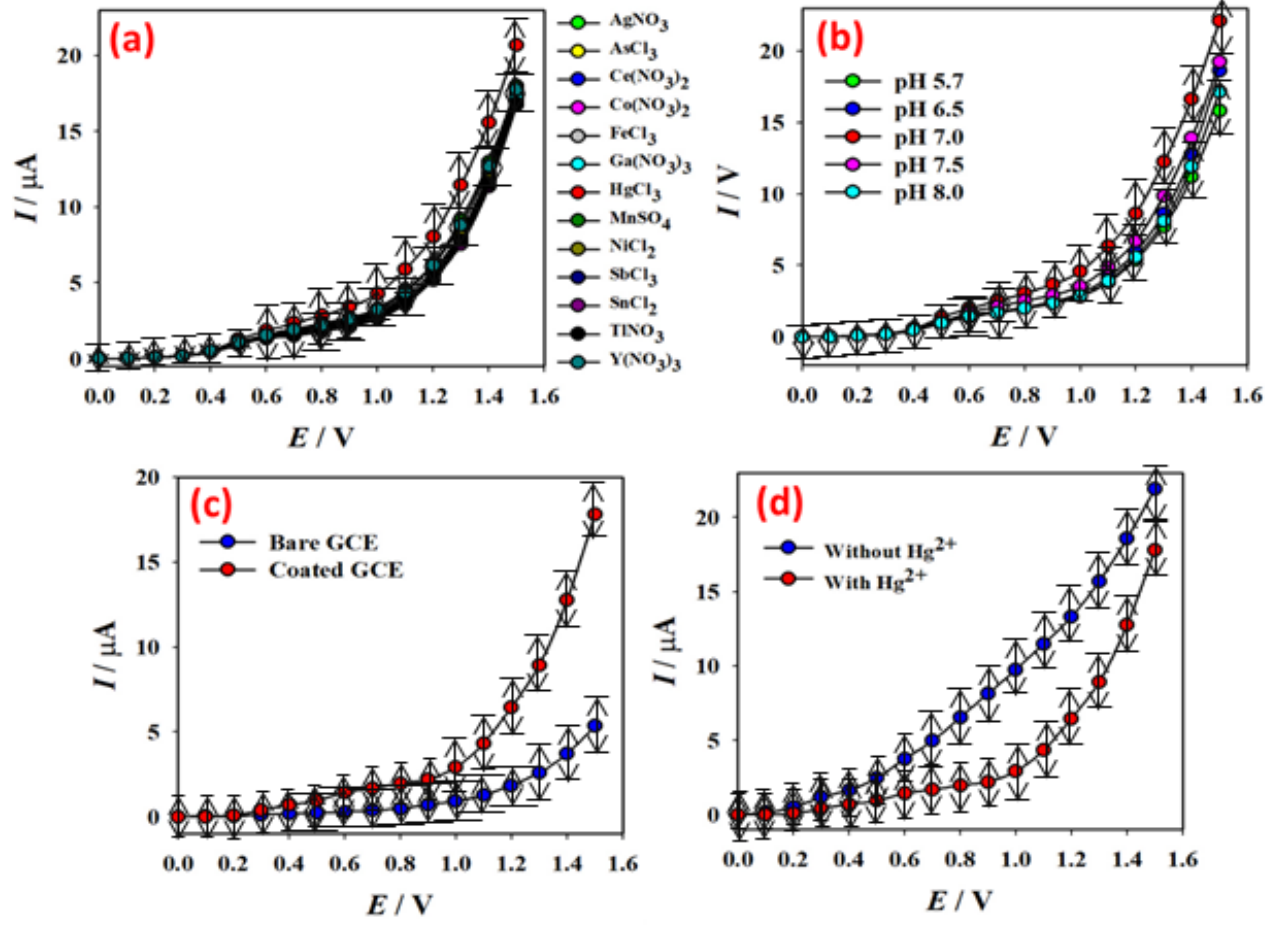
Figure 5. I-V response of modified electrode in the detection of mercury. ( a ) Selectivity study using thirteen chemicals, ( b ) pH optimization, ( c ) bare and PNMPy/nano-Stannous(II)WO 3 modified GCE, and ( d ) without and with the presence of Hg 2+ ion (1.0 µM; 25.0 µL).